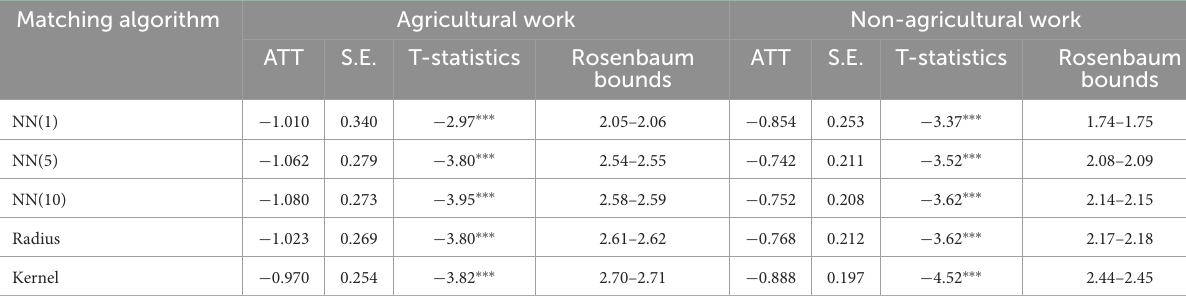
TABLE 7 Heterogeneity in health impacts of internet use by work. Matching algorithm